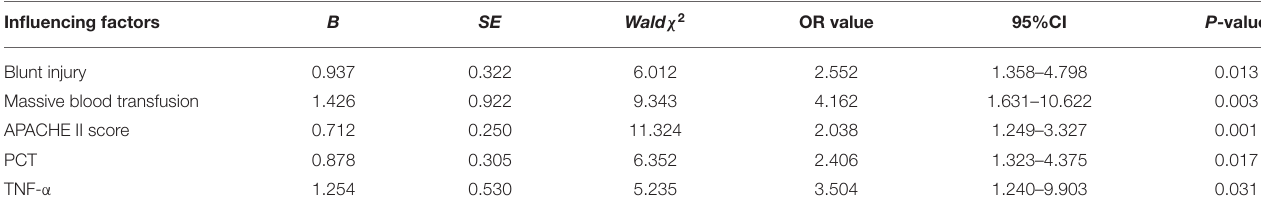
TABLE 3 | Multifactorial analysis of ARDS in combination with thoracic trauma. Influencing